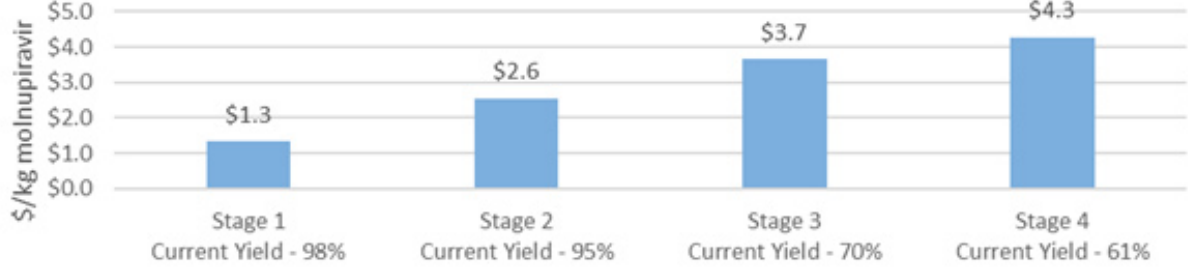
Figure 5. M4ALL Chemical Route from Cytidine maximum COGs decrease per 1% yield improvement in each step.